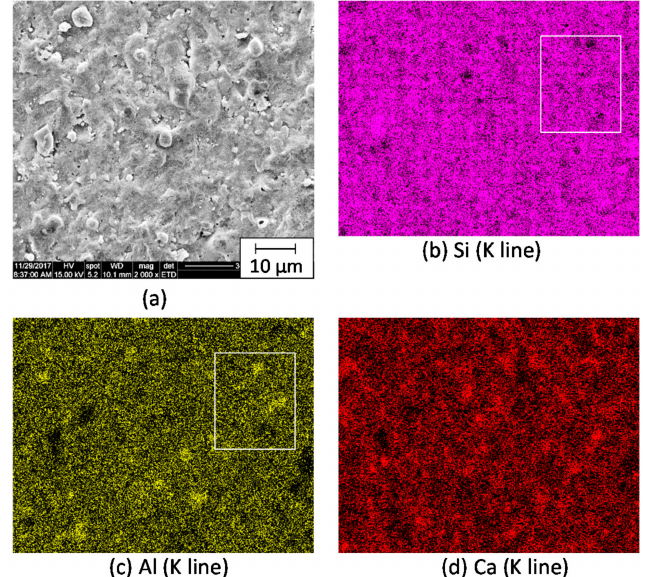
Figure 3. ( a ) Microstructure and ( b – d ) elementary distributions of the shirasu glass with 1.1% porosity, hot-pressed at 950 ◦ C and annealed at 600 ◦ C.